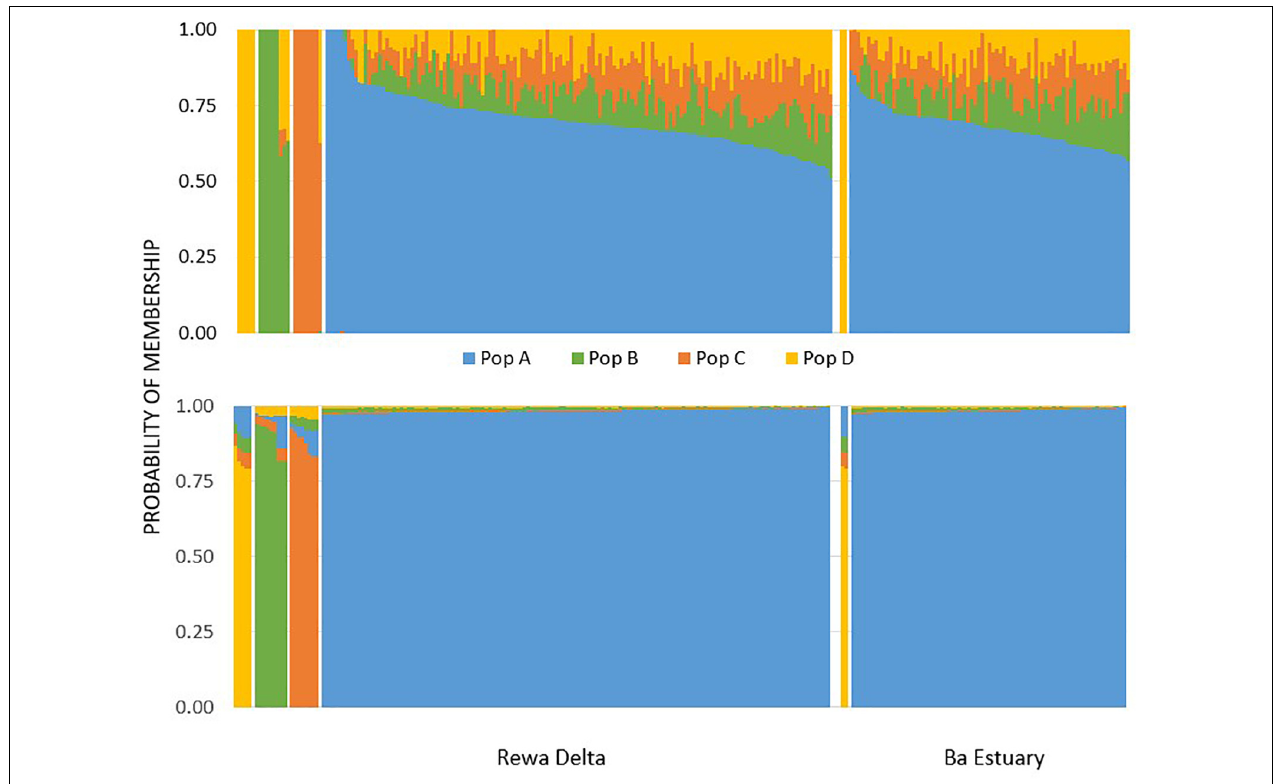
FIGURE 2 | Probability of population assignment based on the optimal k of four for Admixture (top) and assignPOP (bottom) using the SVM